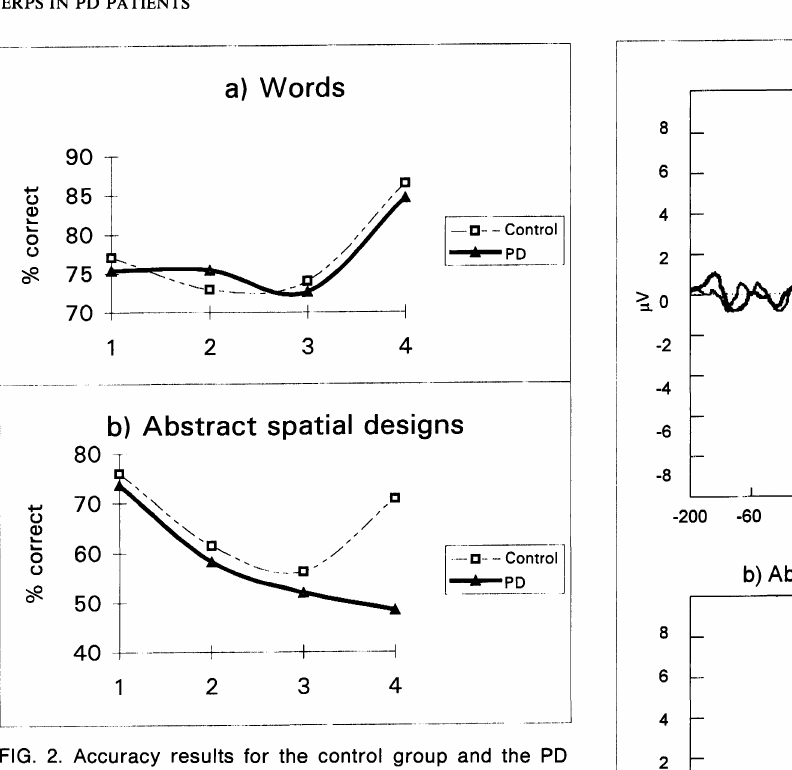
FIG. 2. Accuracy results for the control group and the PD patients for a) words and b) abstract spatial designs.